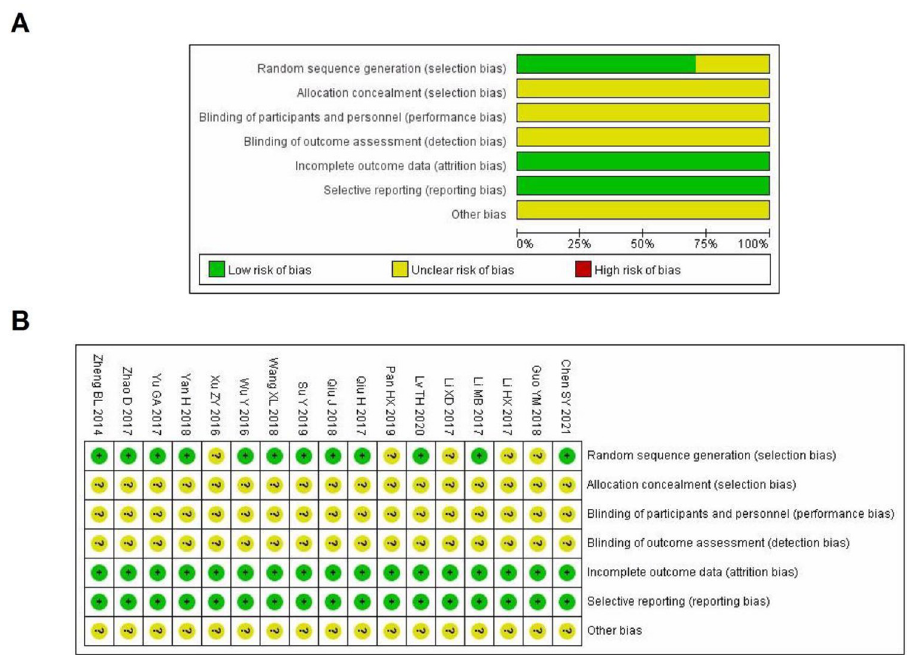
Fig 2. Risk of bias. (A) : Risk of bias graph indicating the review authors’ rating regarding the risk of bias, presented as percentages, across all of the included studies; ( B) :Risk of bias summary indicating the review authors’ judgments on each risk of bias item for each included study. Green color, low risk of bias; yellow color, unclear risk of bias; red color, high risk of bias.